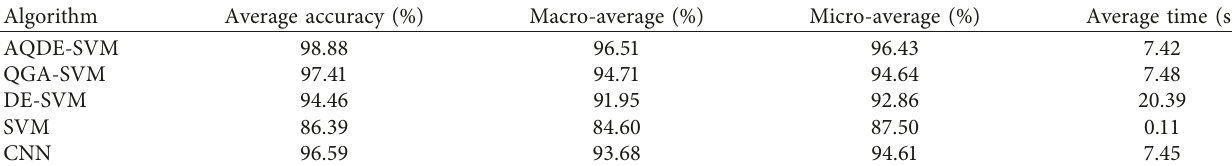
Table 4: Comparison results of fault